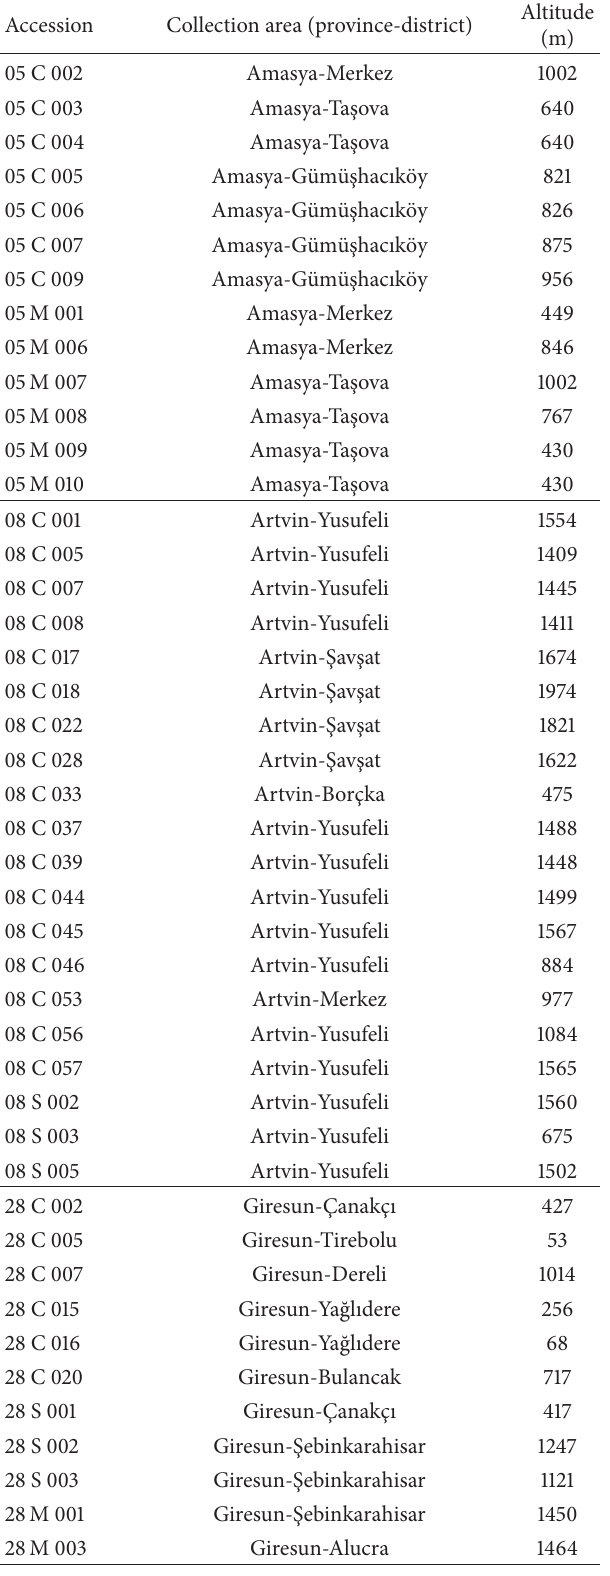
Table 1: The map data of types selected from Central and East Black Sea Regions in Turkey (C: sweet cherry, P. avium ; S: sour cherry, P. cerasus ; M: mahaleb, P. mahaleb ; CA: C. angustifolia